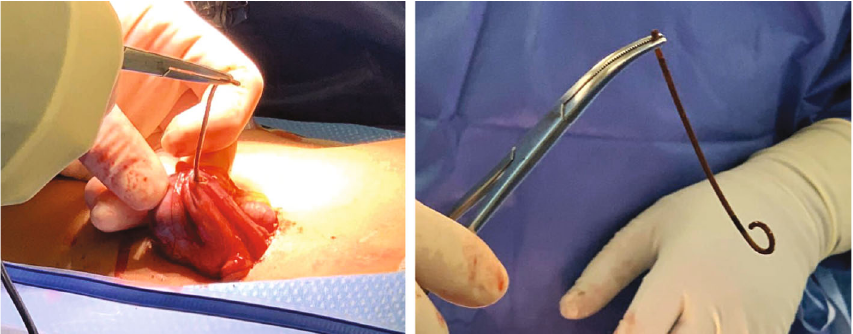
Figure 4: The pigtail catheter in the cecum was removed carefully, and the foreign body was measured 10.0cm in length and 0.3cm in